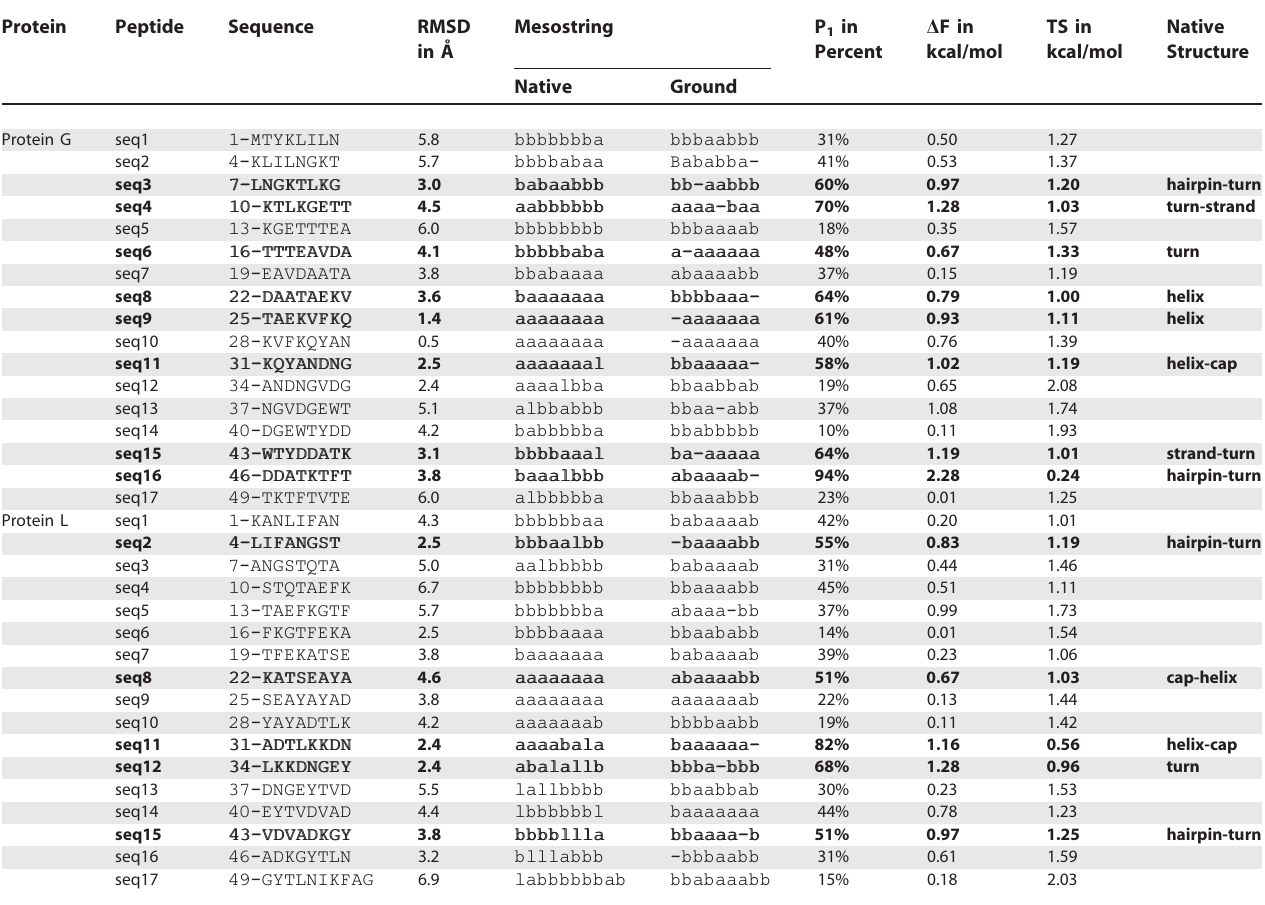
Table 2. Ground Mesostrings of Protein G and Protein L Protein Peptide Sequence RMSD